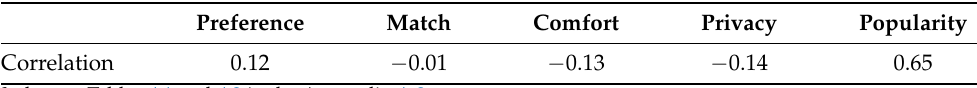
Table 9. Correlations (R) of ratings a for the proposed microgestures between participants from China and the US and